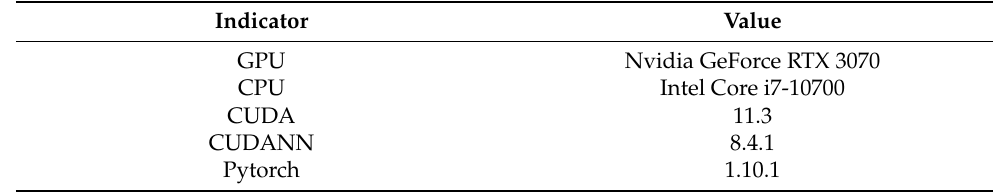
Table 1. The specification of the computer used for model training and testing.